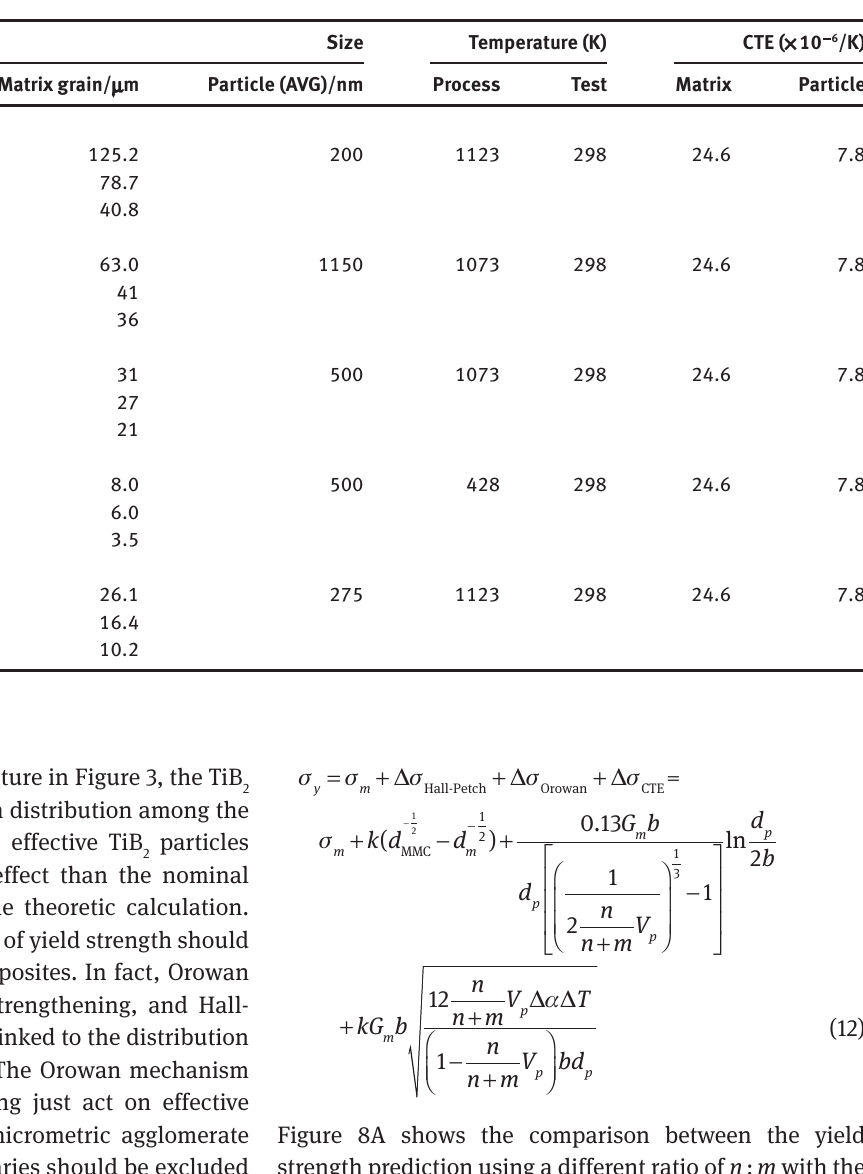
Table 2: Detailed parameters of different TiB